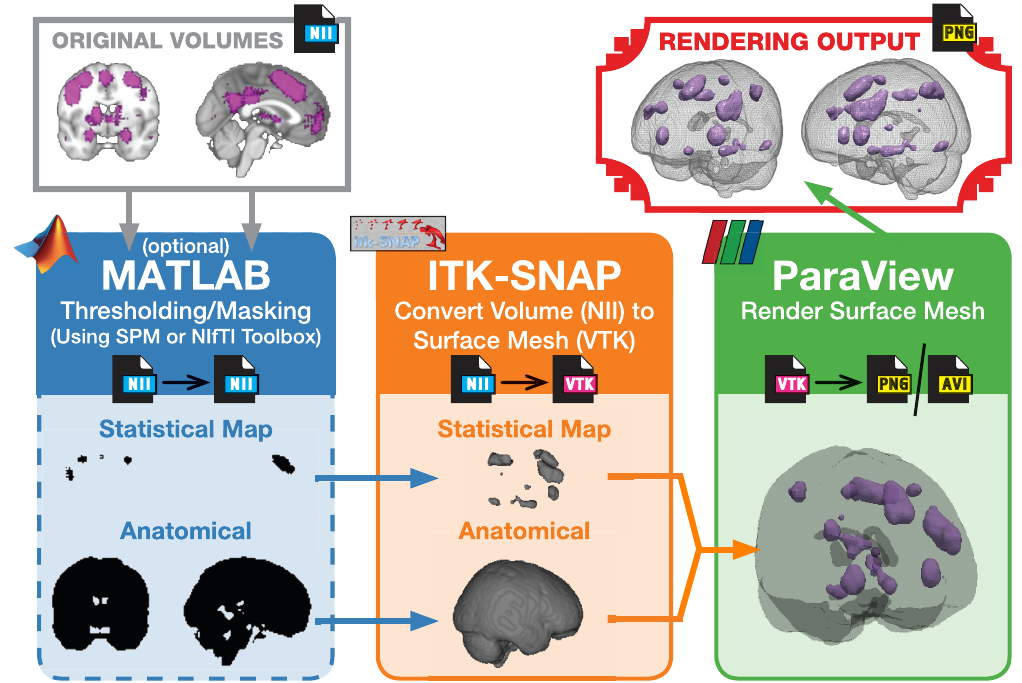
Figure 1. Overview of the processing